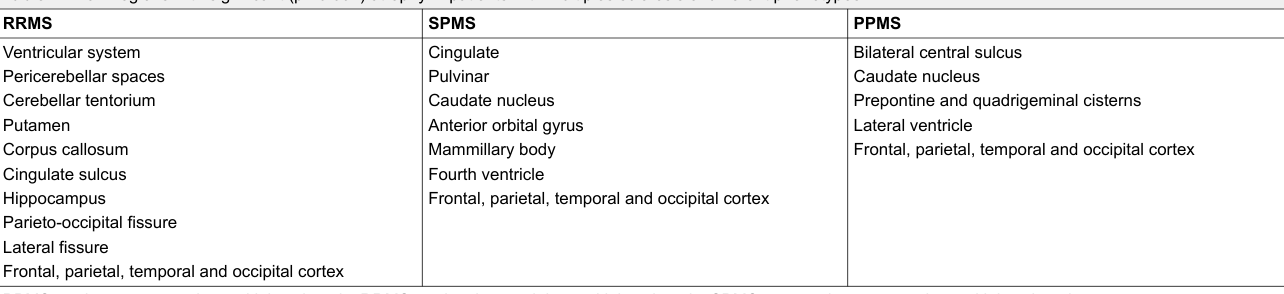
Table 2: Brain regions with significant (p <0.001) atrophy in patients with multiples sclerosis of different phenotypes.